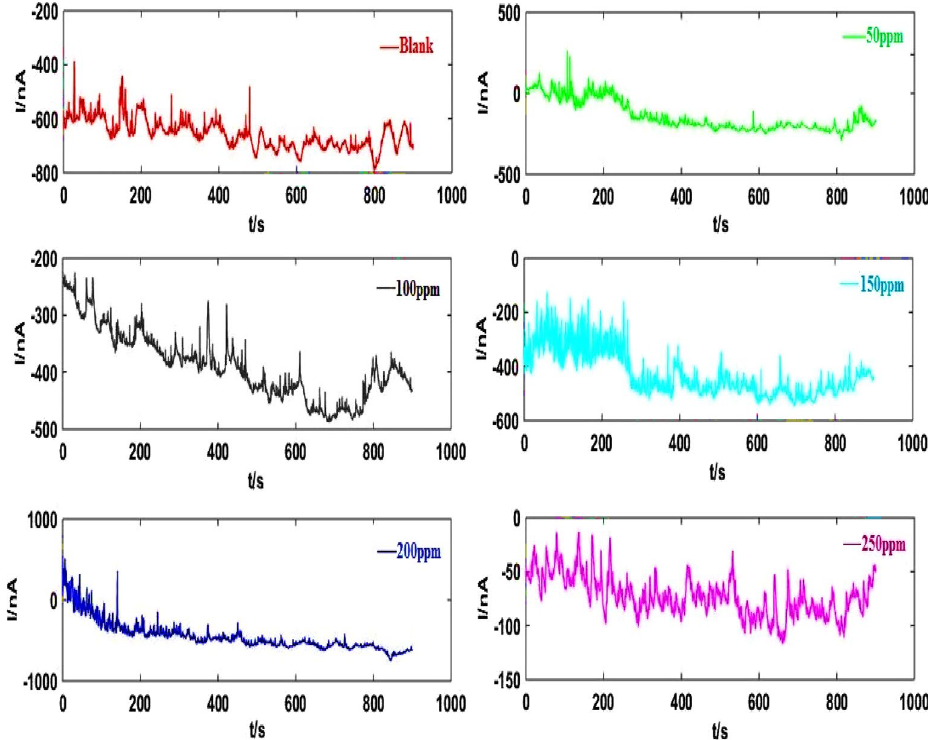
Figure 4. EN current records before elimination trend of As-Co in absent and presence of varies concentrations of RA/Ag